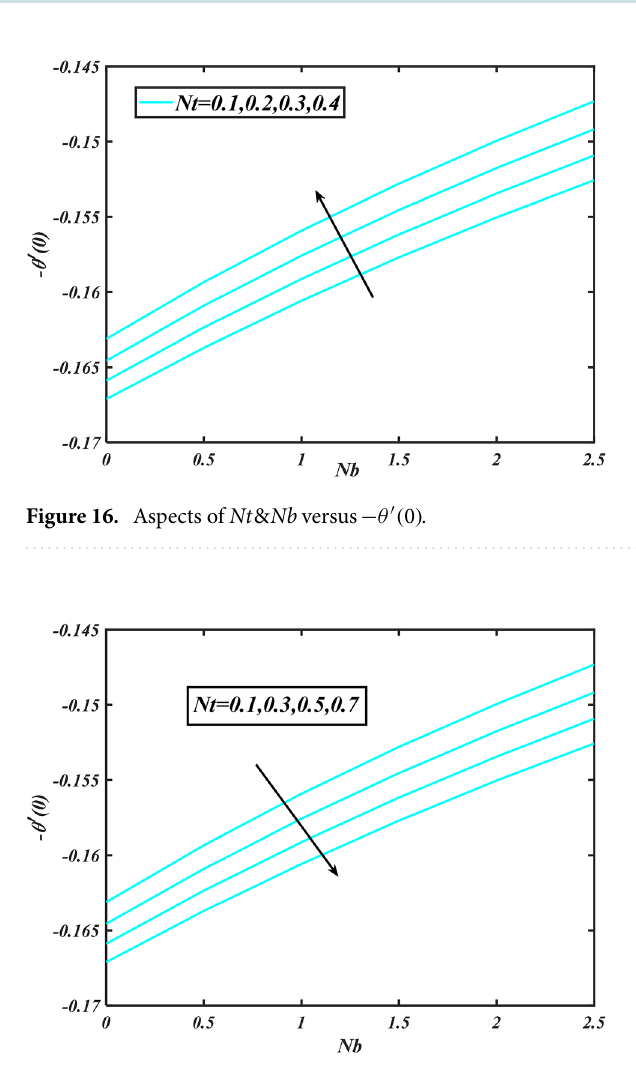
Figure 17. Aspects of Nt & Nb versus − θ ′ ( 0 ) .